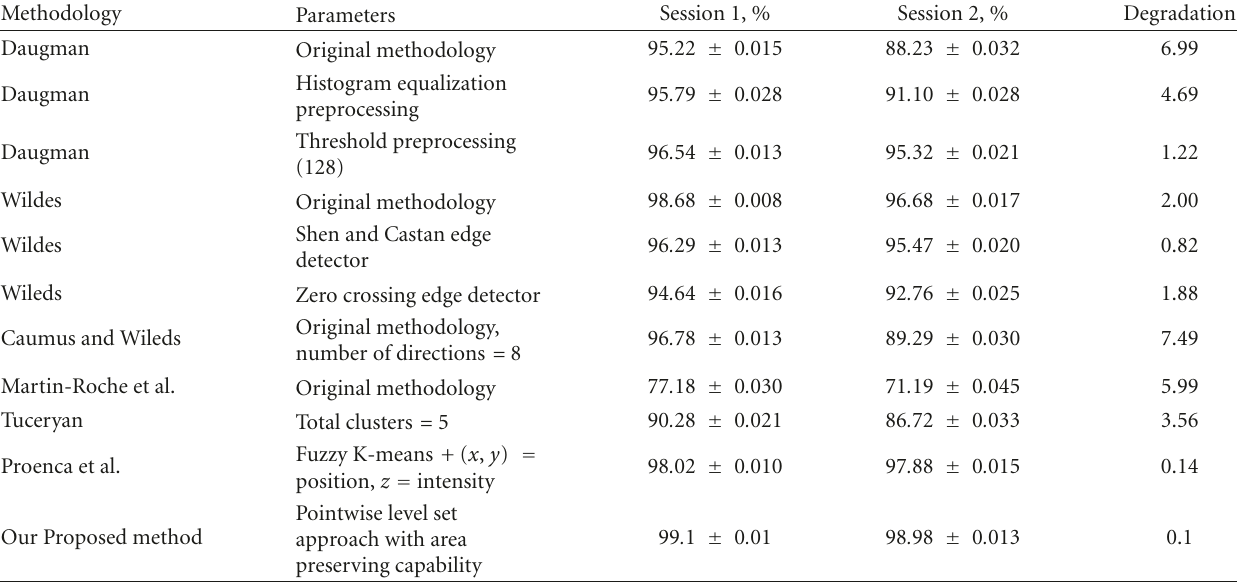
Table 1: Comparing localization accuracy of di ff erent methods using Ubiris database. The whole table entries are taken from reference [19], excluding the last row which contains the results obtained using our